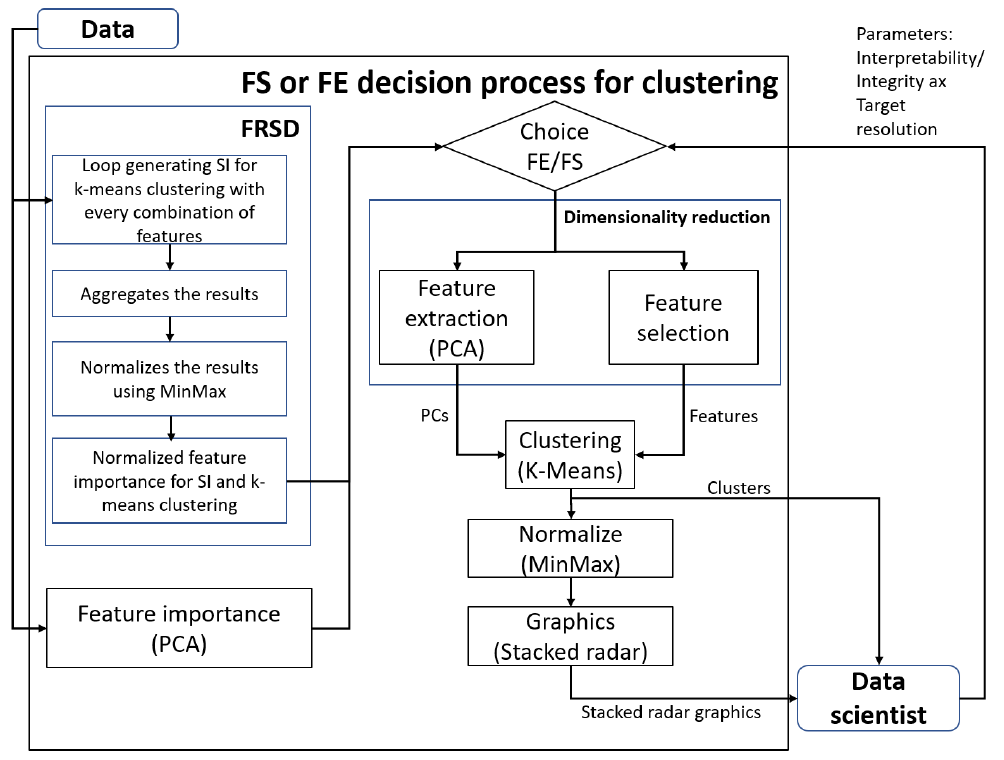
Figure 2. Architecture of the